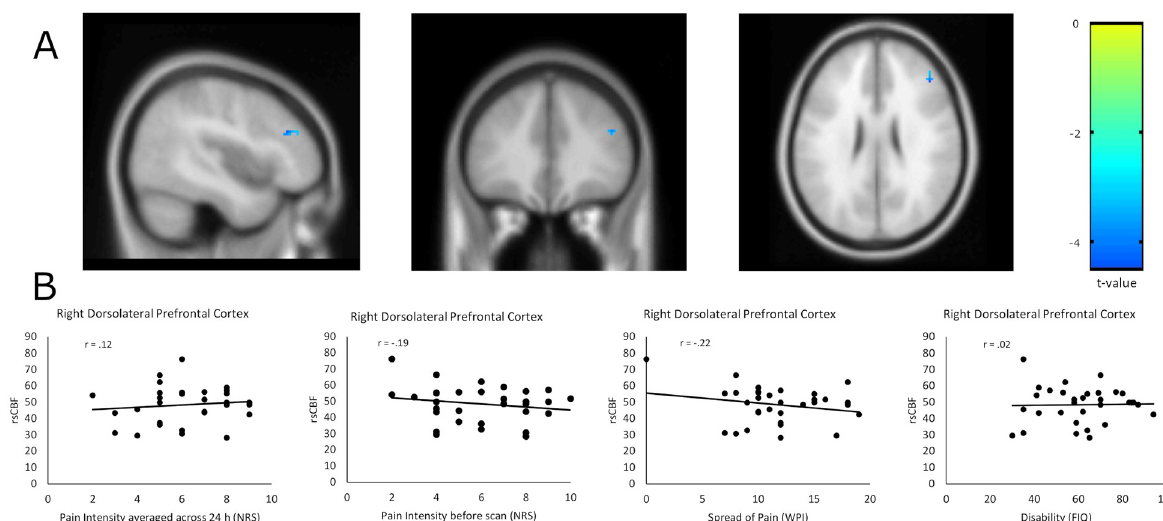
Fig 1. Unadjusted difference in resting-state cerebral blood flow (rsCBF) between cases (N = 32) and controls (N = 32) in the right Dorsolateral Prefrontal Cortex (x = 44; y = 32; z = 26) controlling for mean global rsCBF at cluster-level of 10 voxels (A) and correlation of pain characteristics with rsCBF of this region within patients (N = 32) (B). Displayed are cluster-sizes of > 10 voxels with colors indicating t- values. NRS: Numerical Rating Scale from 0 (no pain) to 10 (maximum pain). WPI: Widespread pain index from 0 (no body region with pain) to 19 (all body regions with pain). FIQ: Fibromyalgia Impact Questionnaire from 0 (no disability) to 100 (most severe disability). r: correlation coefficients.